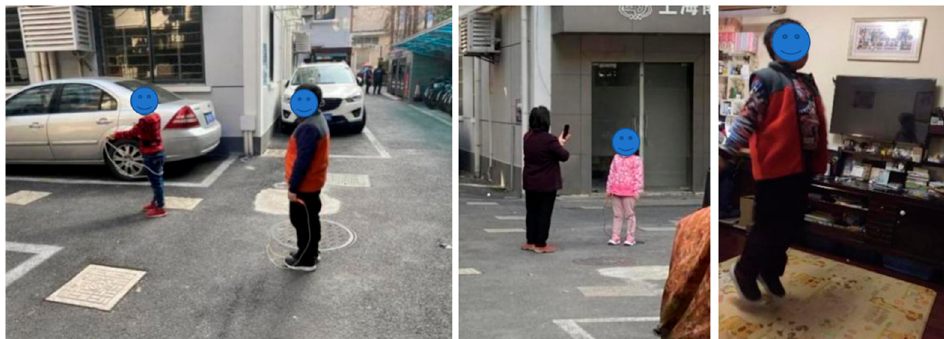
Figure 1. A snapshot from one of the observation sessions. (2)